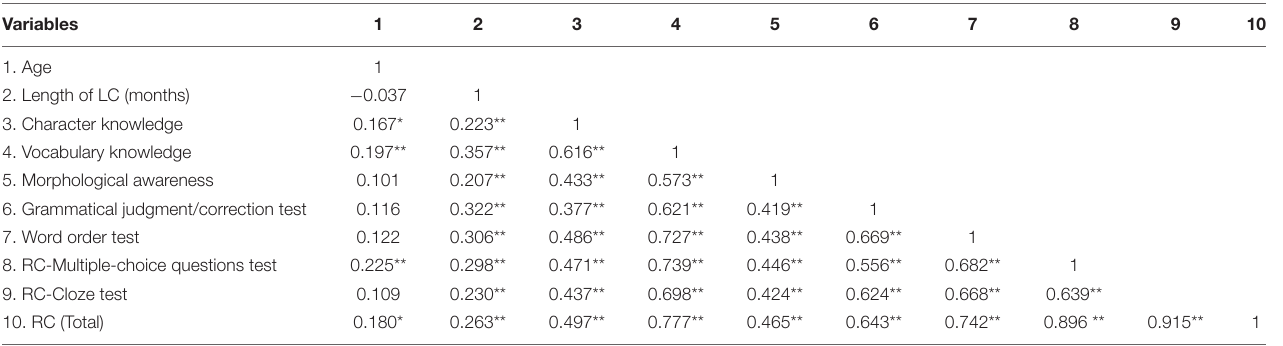
TABLE 2 | Partial correlation among all variables.